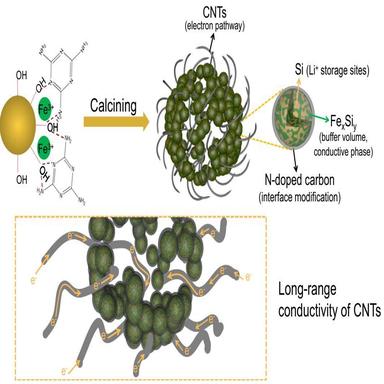
Schematic illustration of the process of Si/FexSiy@NC/CNTs.